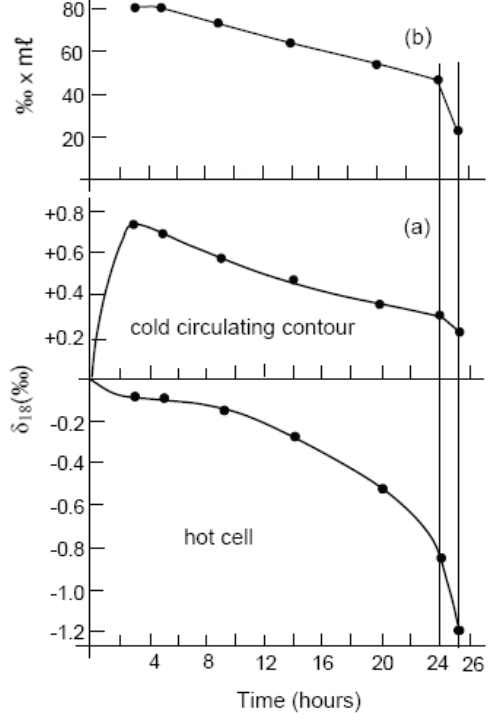
Fig. 10 An extended experiment relative to fig. 8: membrane 75 μ , temperatures in hot and cold cells are 90 and 40 ◦ C, respectively, initial water quantity in the hot cell is 190 ml and in the cold cell is 120 ml, pressure in the hot cell is 7 atm, hydraulic flow from hot to cold cell is 5.1 ml h − 1 . Initial water in both cells is normal water. After the